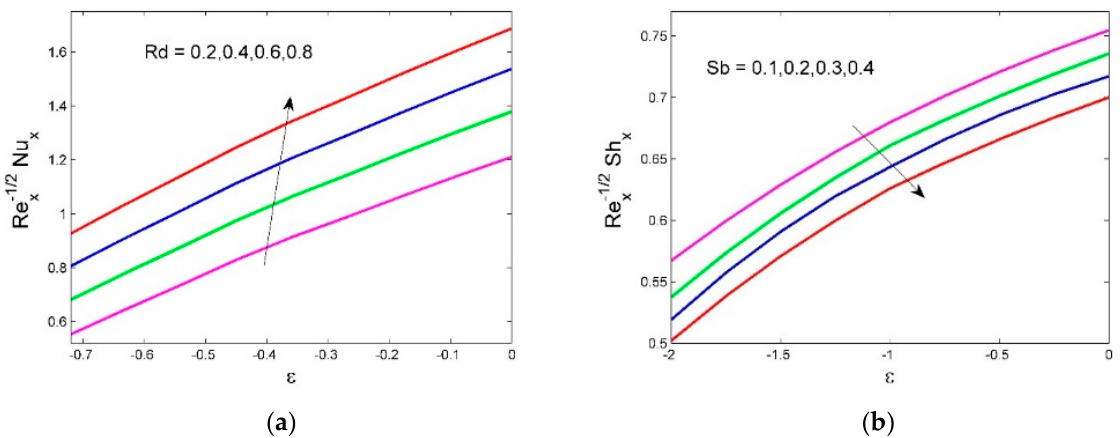
Figure 10. Impacts of Rd against ε on Nu and Sb against ε on Sh .